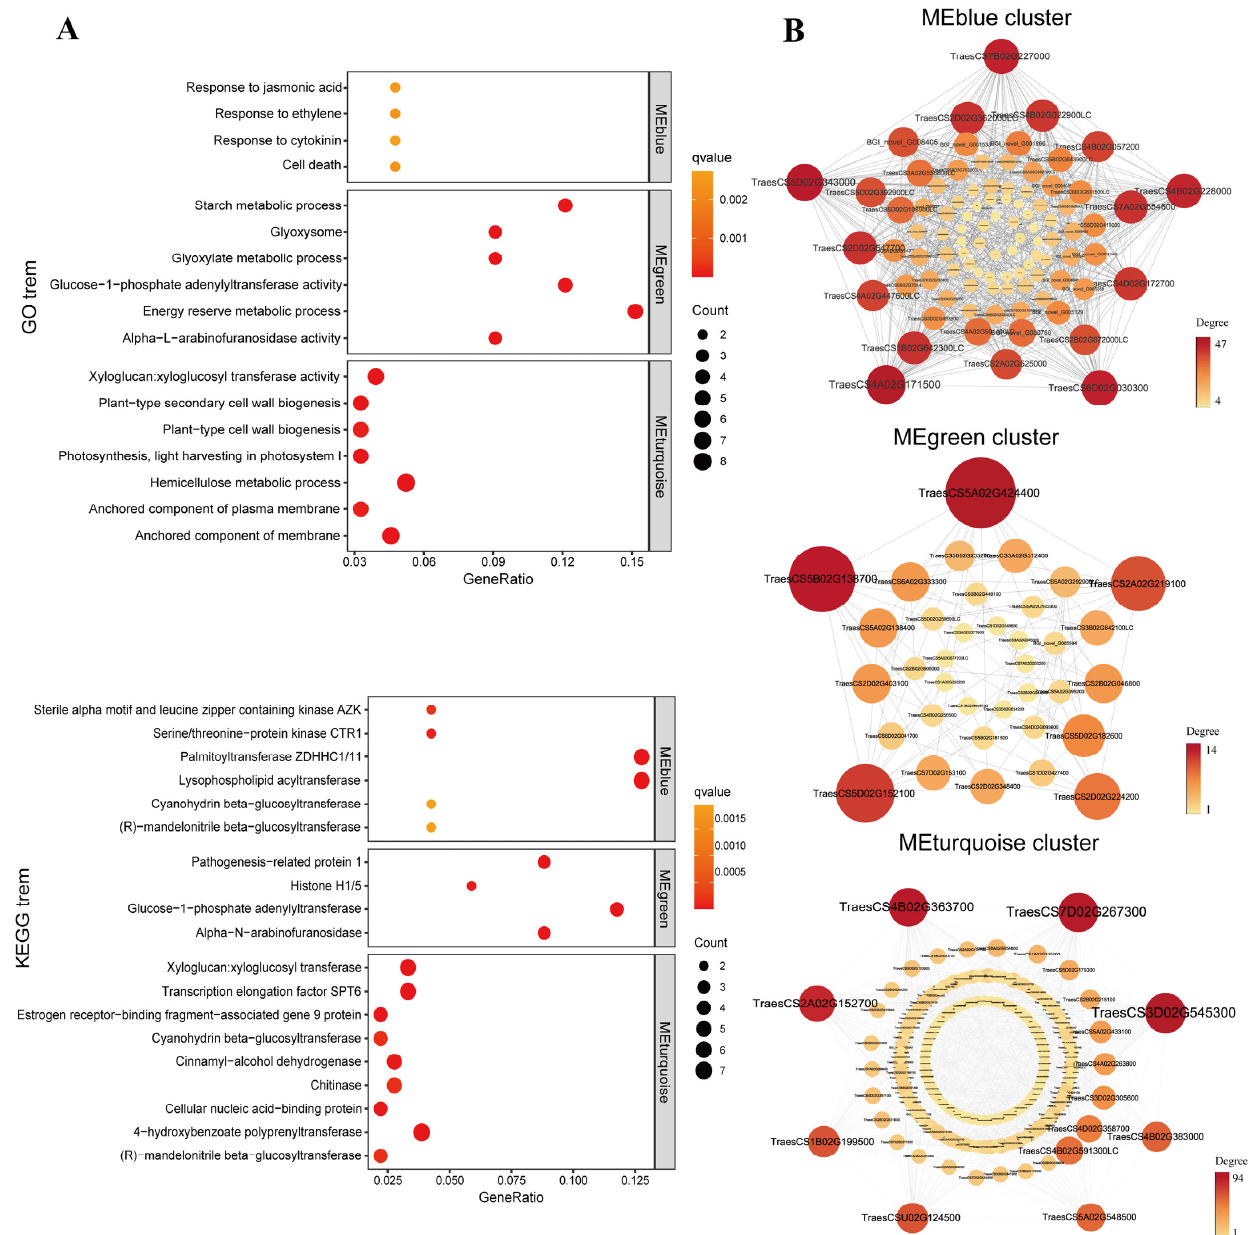
Figure 5. Analysis of module MEblue, MEgreen, and MEturquoise. ( A ) The GO enrichment and KEGG Orthologs analysis. The bubble size indicated the number of genes enriched in the GO term (or KEGG Orthologs), and the color represented the degree of significance. ( B ) The co-expression network of DEGs in MEblue, MEgreen, and MEturquoise modules. Degree indicated the number of lines connected to the node, and each line connected two different genes.